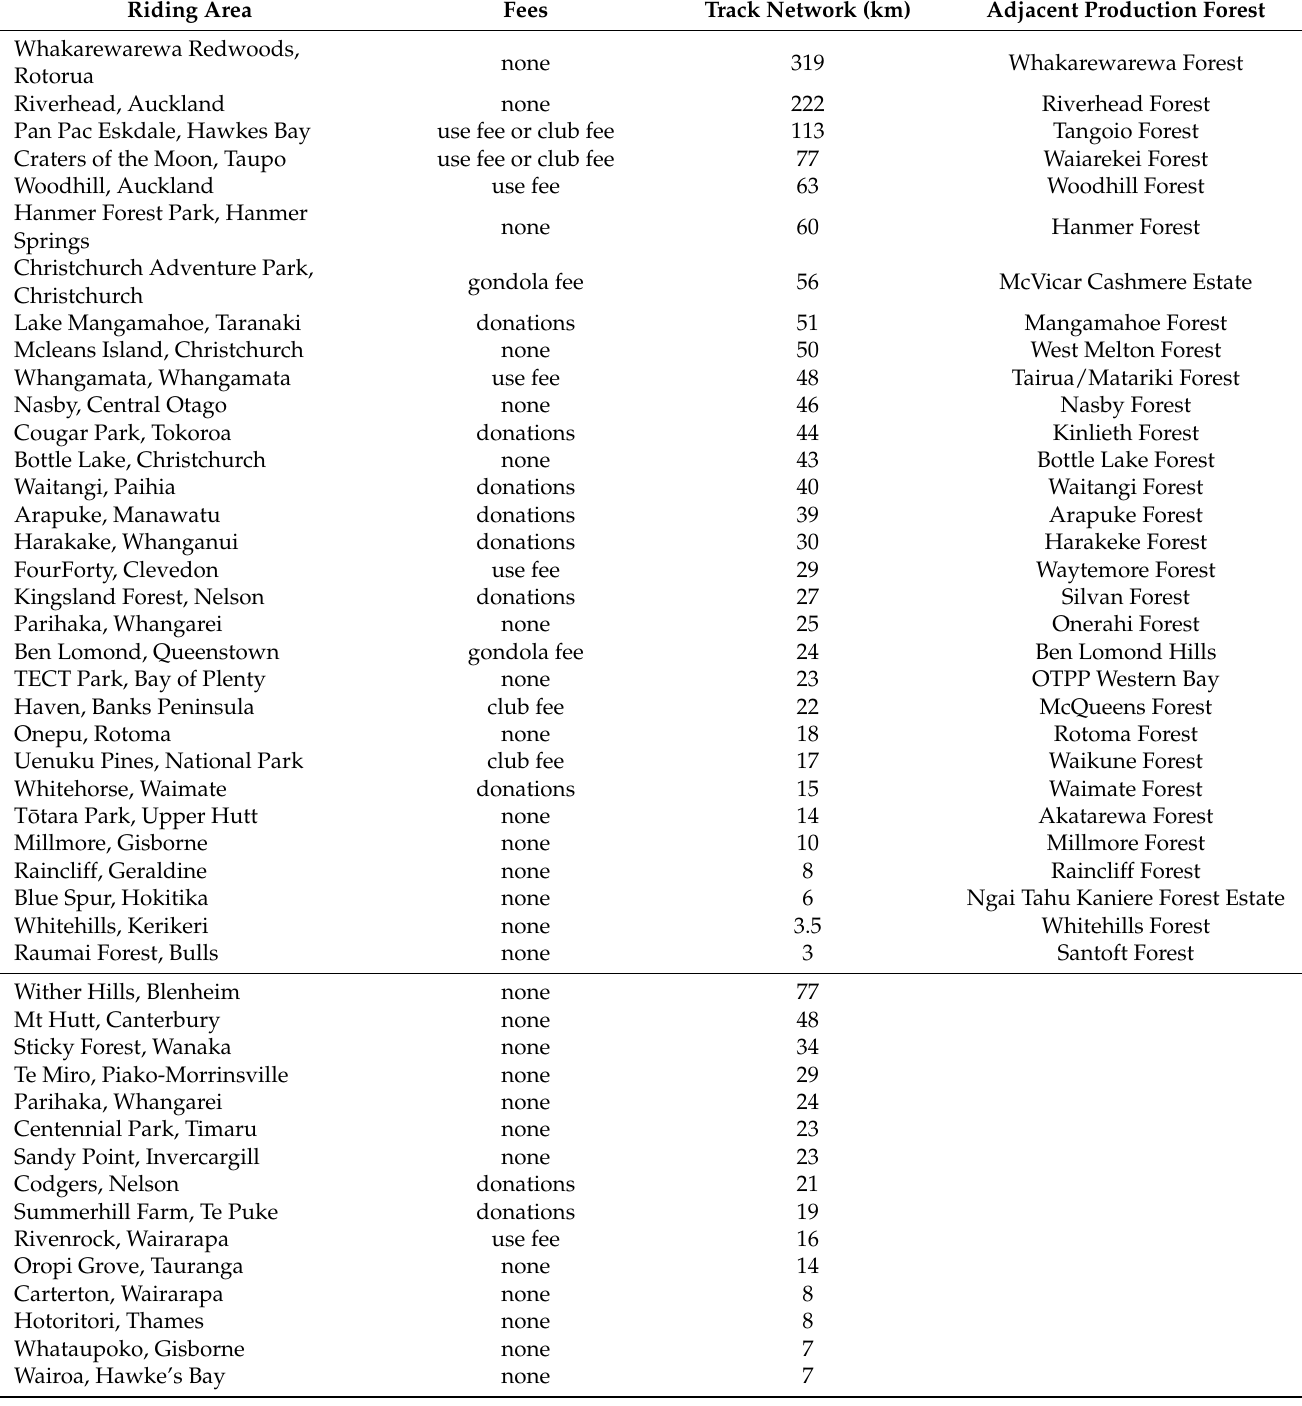
Table 1. Mountain bike parks in production plantation forests (Source: trailforks.com (accessed on 28 June